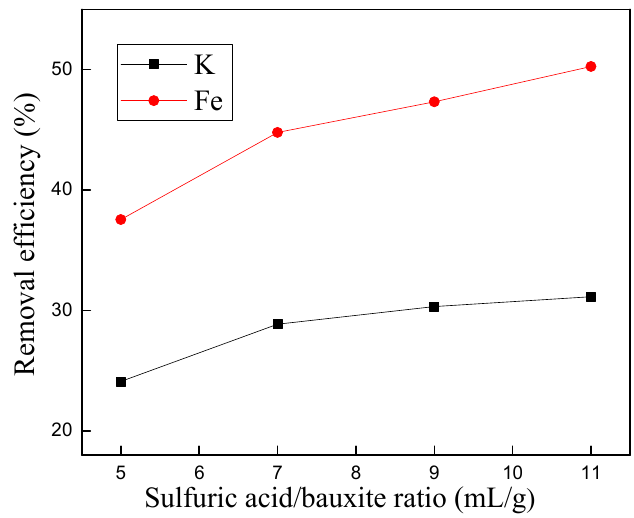
Figure 9. Effect of sulfuric acid/bauxite ratio on the removal efficiency.